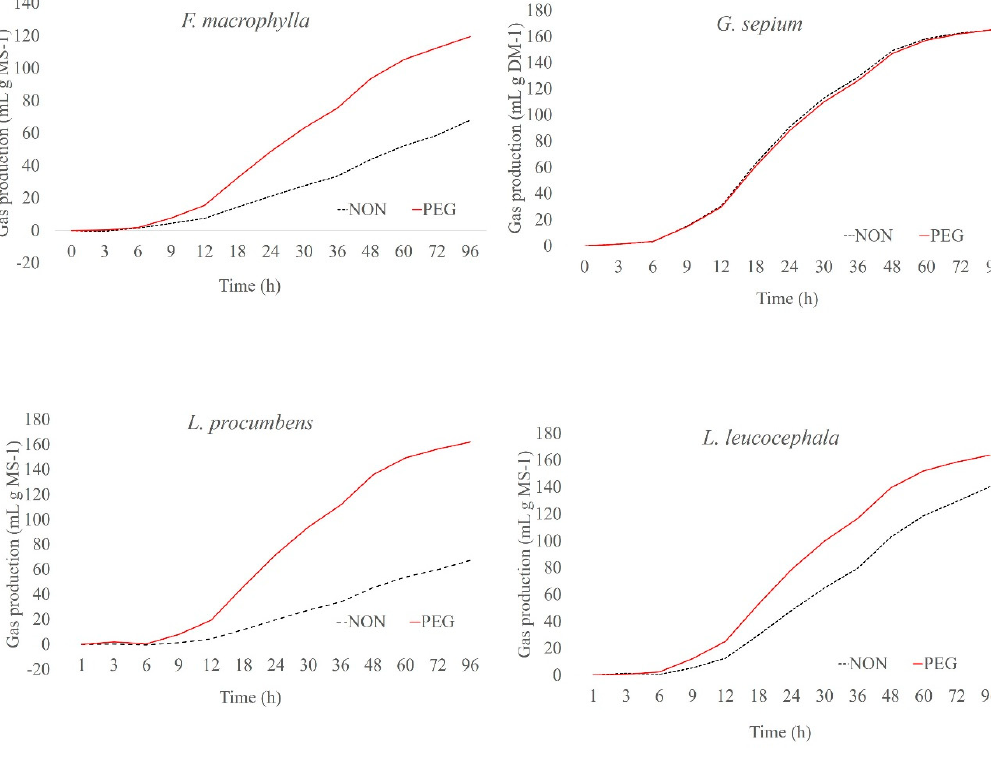
Figure 2. Cumulative gas production curves of Flemingia macrophylla , Gliricidia sepium , Lespedeza procumbens , and Leucaena leucocephala incubated at the end of 96 h.